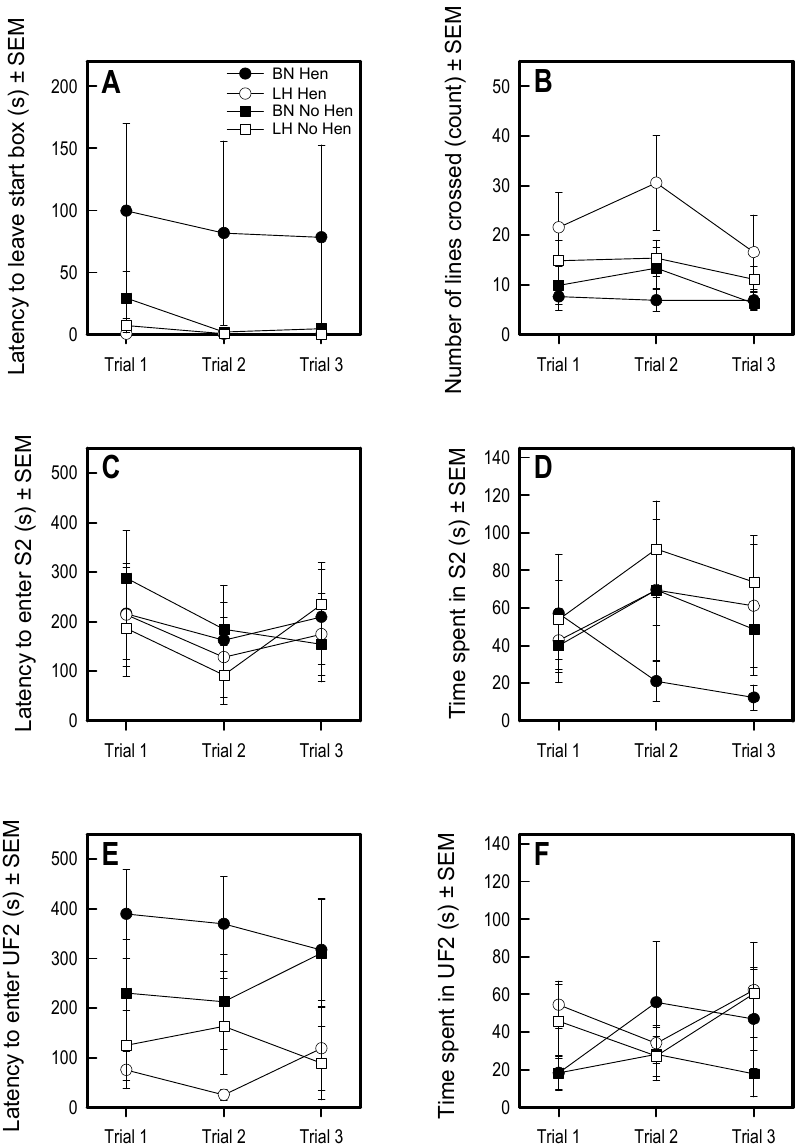
Figure 5. Relevant behavioral measures in the Social recognition Y-maze. Significant e ff ects of genetic strain were seen in ( A ) latency to leave start box, ( B ) number of lines crossed, and ( E ) latency to enter UF2. No significant di ff erences were seen in latency to enter ( C ) FA2 ( D ) total time in FA2, nor in ( F ) time spent in UF2; no significant e ff ects of session or interactions were observed in any variable. Lines represent averages and